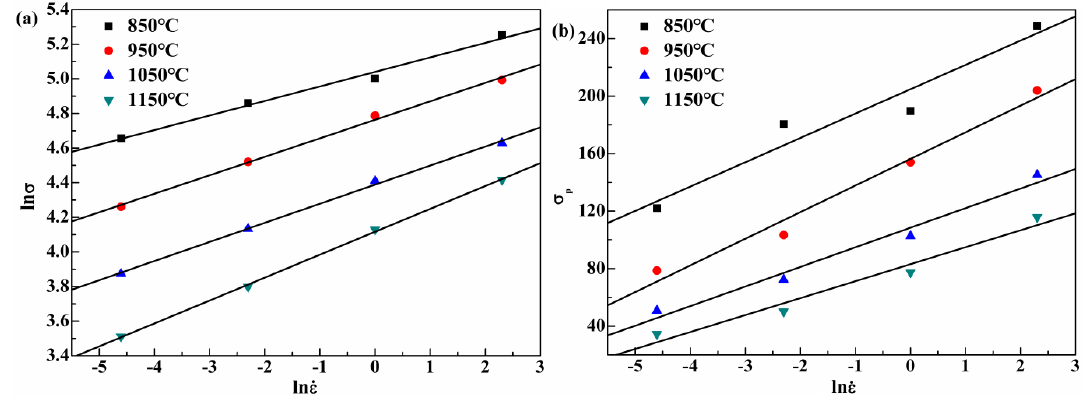
. ε . ε σ εln  Figure 4. ( a ) ln σ − ln plots; and ( b ) σ p − ln plots under different deformation Figure 4. ( a ) ln σ εln  plots; and ( b ) p plots under different deformation conditions.